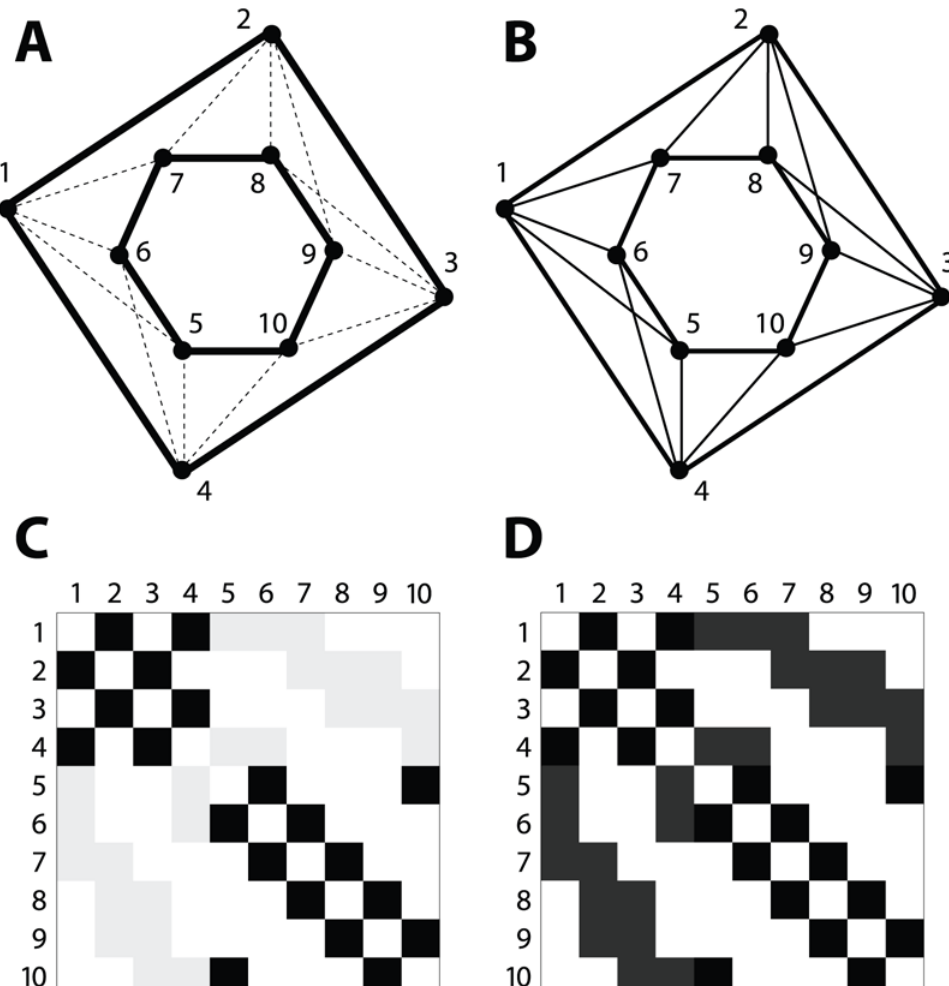
Figure 1. Community structure in graphs and affinity matrices. (A) A graph with 10 vertices and 22 edges. Thick black lines denote strong edges and thin dotted lines denote weak edges. The edge classes have been drawn so that the distinction between them is prominent: {1,2,3,4} and {5,6,7,8,9,10} are intuitive communities of connected vertices. (B) Ostensibly the same graph as in the previous panel, with the edge classes drawn to obscure the communities that were so prominent. (C) Depiction of the affinity matrix that corresponds to the graph in panel (A). Rows and columns denote vertices, and each (row,column) entry of the matrix is shaded to indicate the strength of its corresponding edge, if any. As drawn, the contrast between strong and weak edges is sufficient to reveal two communities as clusters of darkly shaded squares along the matrix main diagonal. (D) Depiction of the affinity matrix that corresponds to the graph in panel (B). With less contrast between edge classes, the pattern along the main diagonal is largely obscured.